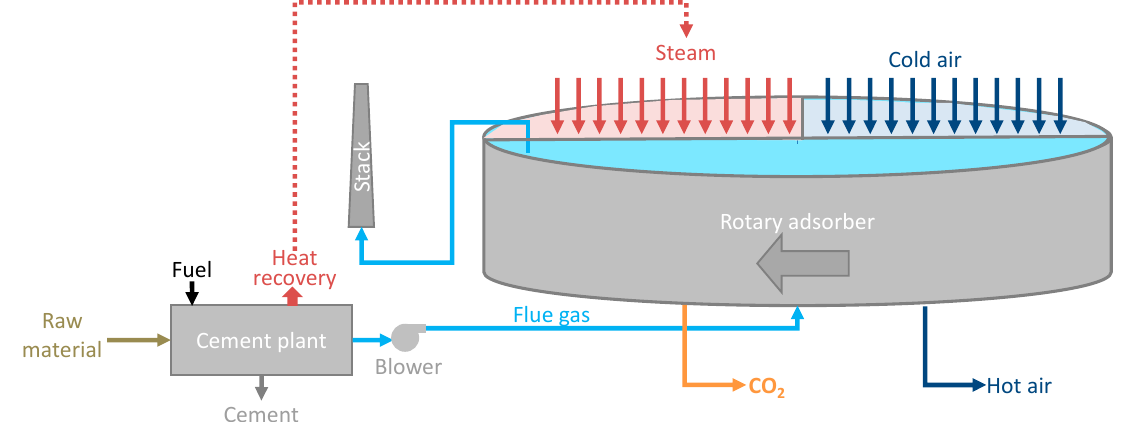
Figure 10. Simplified flow diagram of Svante’s Veloxotherm TM process integrated in a cement plant.